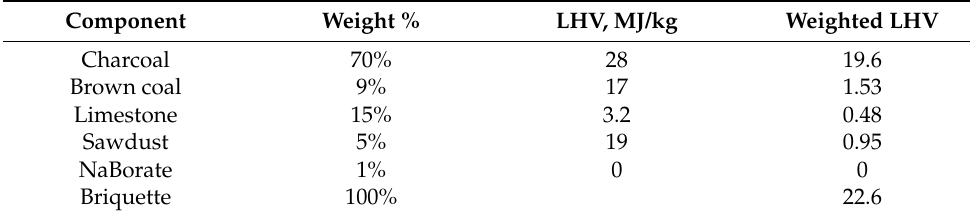
Table 1. Composition of Kingsford charcoal